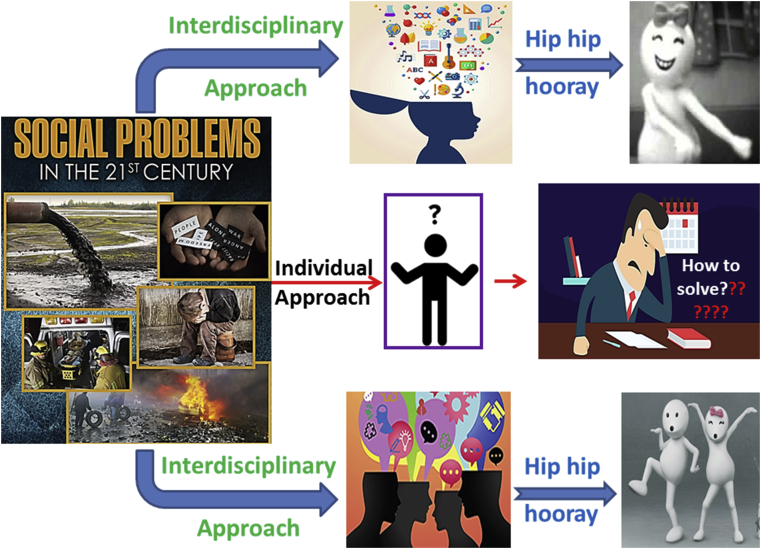
Representing figure showing the need of improving thought process for interdisciplinary approaches rather than on a single thought process to solve the problems of the society (adapted from The Open University, American Psychological Association, Kendall/Hunt Higher Education, zozoovodafone, India, all images were downloaded from Google images with above citations are acknowledged).